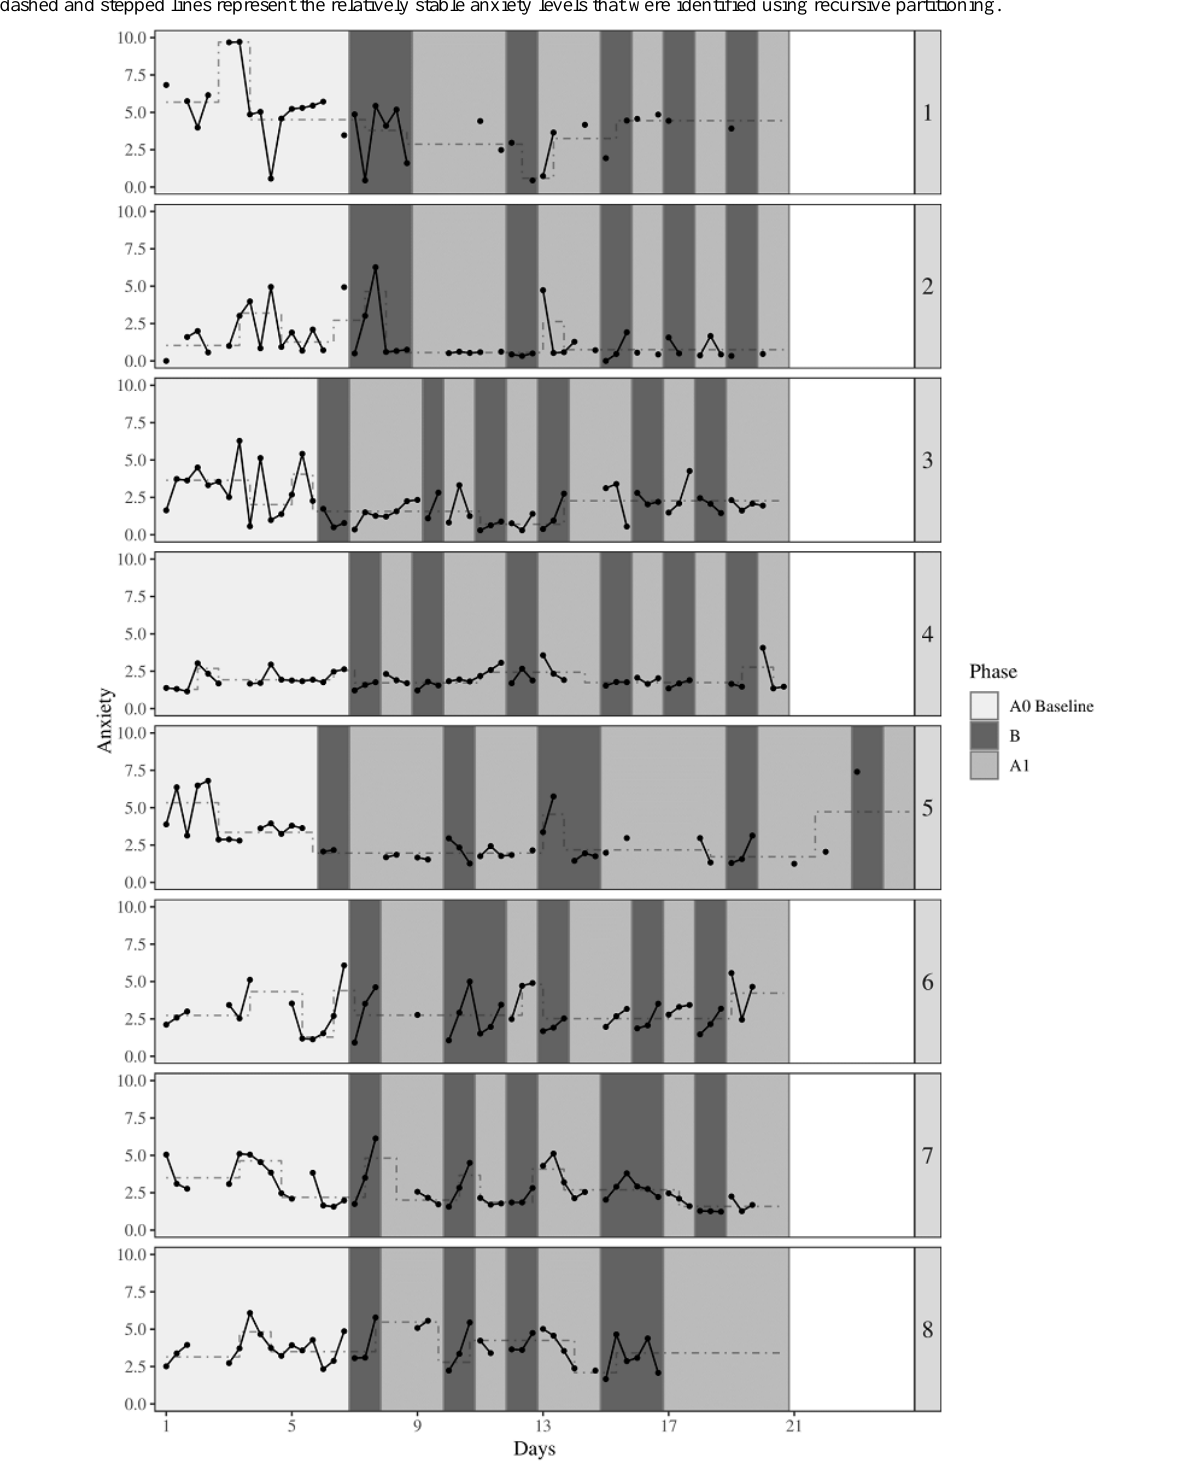
Figure 2. The effect of DEEP on anxiety for 8 adolescents. Every 3 data points represent 1 day (measured around 10:00 AM, 12:00 PM, and 2:00 PM). The dashed and stepped lines represent the relatively stable anxiety levels that were identified using recursive